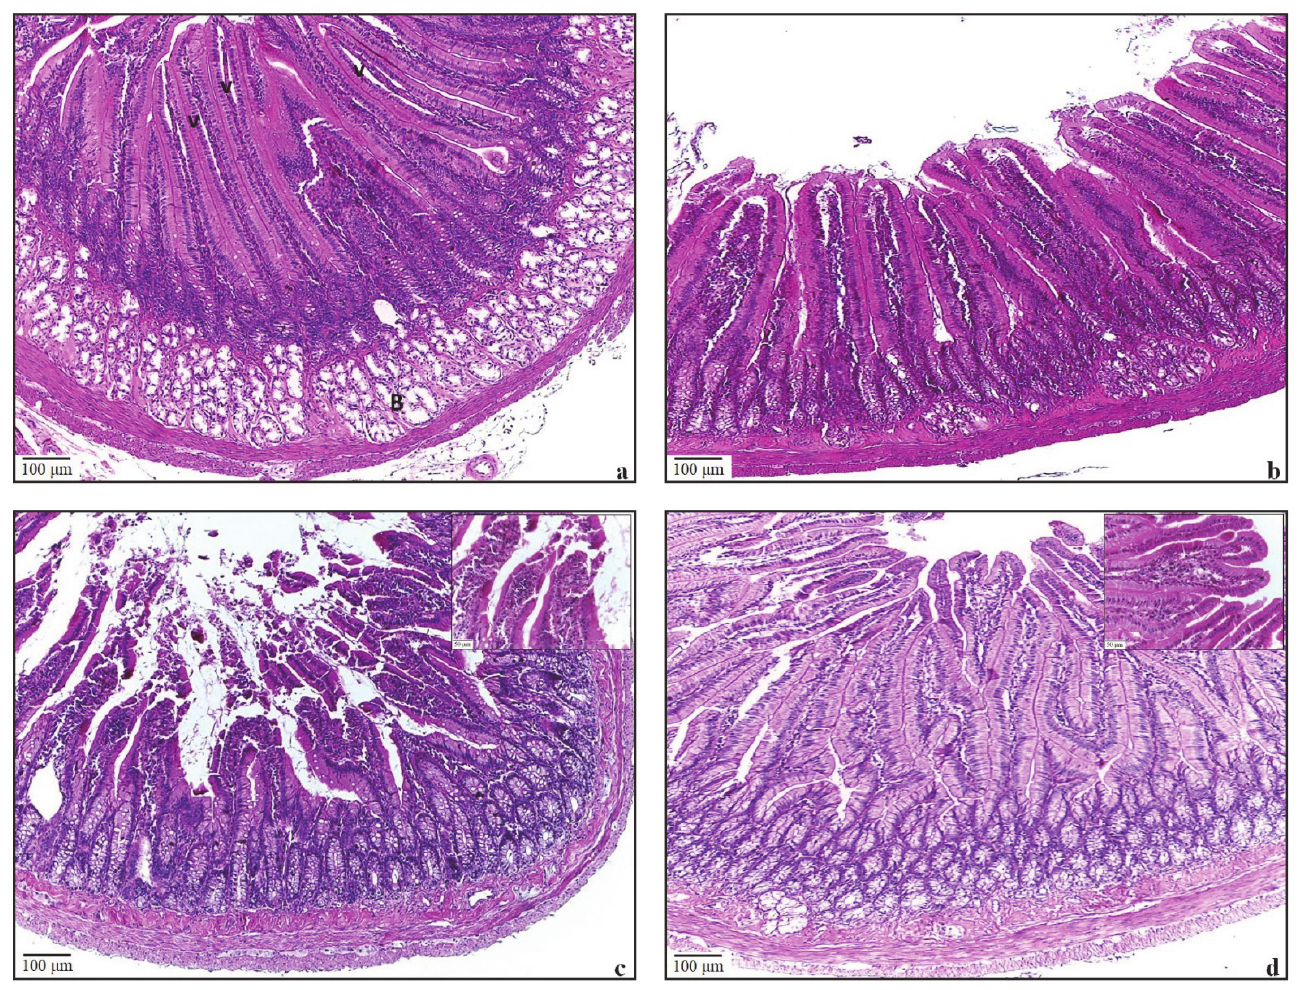
Figure 4. The microscopic images of HE-stained slides of the small intestine tissue. Bar = 100 μ m; enlarged area Bar = 50 μ m. ( a ) The structure of the small intestine of the control group is shown; Villus (v) and Brunner’s glands (B). ( b ) The structure of the small intestine in the ALA-only group is similar to the control group. ( c ) Shedding of villi and irregularity in enterocytes are seen in the Mucositis group. ( d ) In the Mucositis + ALA group, it is seen that the villi structures are smooth.